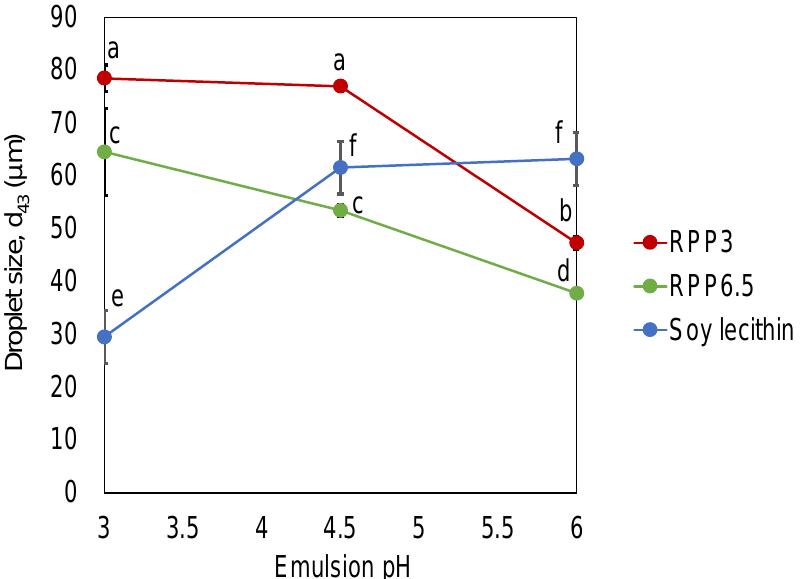
Figure 3. Emulsion droplet size ( d 43 ) as a function of emulsion pH in emulsions stabilized by rapeseed protein precipitated at pH 3 (RPP3) pH 6.5 (RPP6.5), and soy lecithin. Emulsions were 33% oil ‐ in ‐ water emulsions produced by high shear homogenization. Emulsifier concentrations in the emulsions were 10 mg protein/mL oil for the rapeseed formulations and 10 mg/mL oil for the de ‐ oiled lecithin formulations. Data is an average from four measurements for each formulation. Different letters indicate significant differences between the different datapoints, p < 0.05.